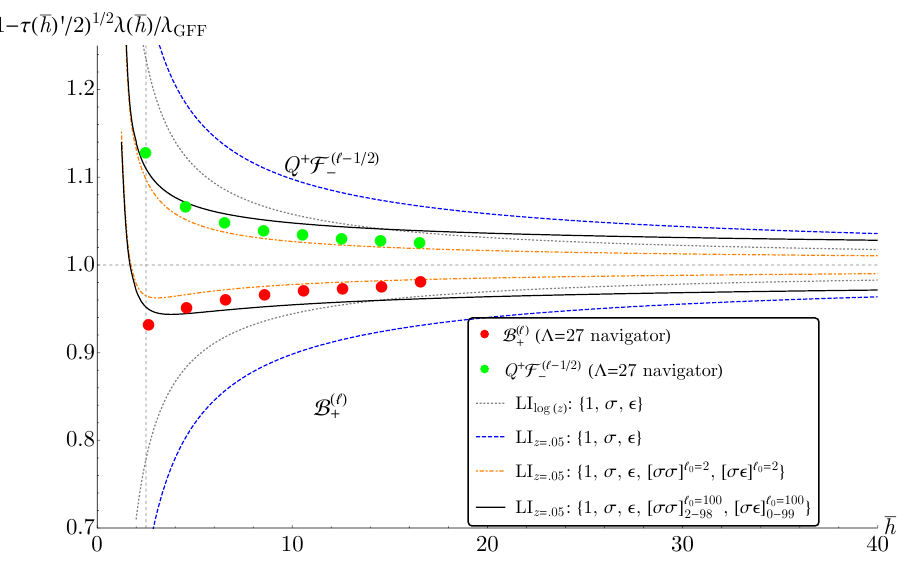
Figure 5 . Leading twist OPE coefficients in the B ( ‘ ) formula after inputting t -channel exchange of various sets of operators. The vertical dashed line is at the stress-tensor location ¯ h = 5 / 2 . The curves are compared with extremal spectrum data from the minimum of the navigator function at Λ = 27